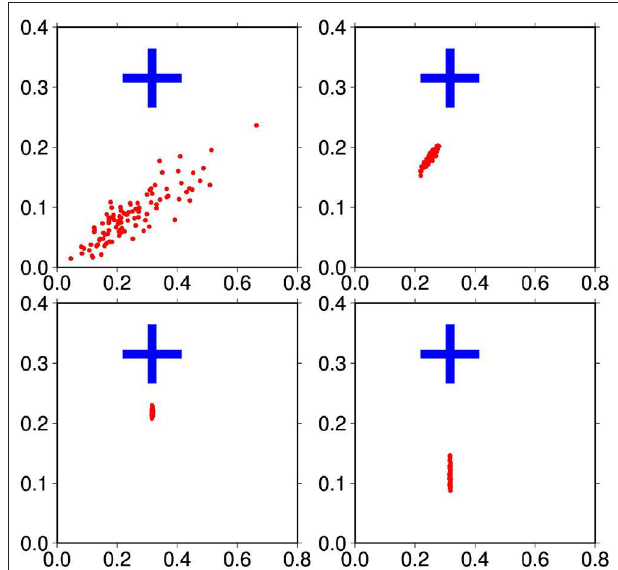
FIGURE 12 | Distribution of the fraction of the sphere where the field is equal to zero (x-axis) and where both the field and the true field are equal to zero (y-axis), as obtained: from the prior ensemble (top left) , from the updated ensemble using the local observations only (top right) , from the updated ensemble using all observations (bottom left) , and from the updated ensemble using observation y o c only (bottom right) .